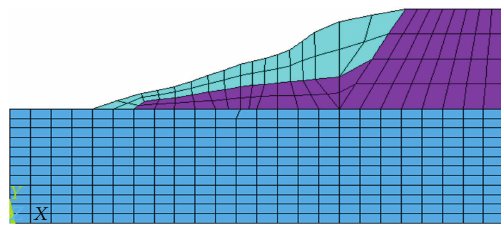
Figure 8: The finite element model of QC10 section.